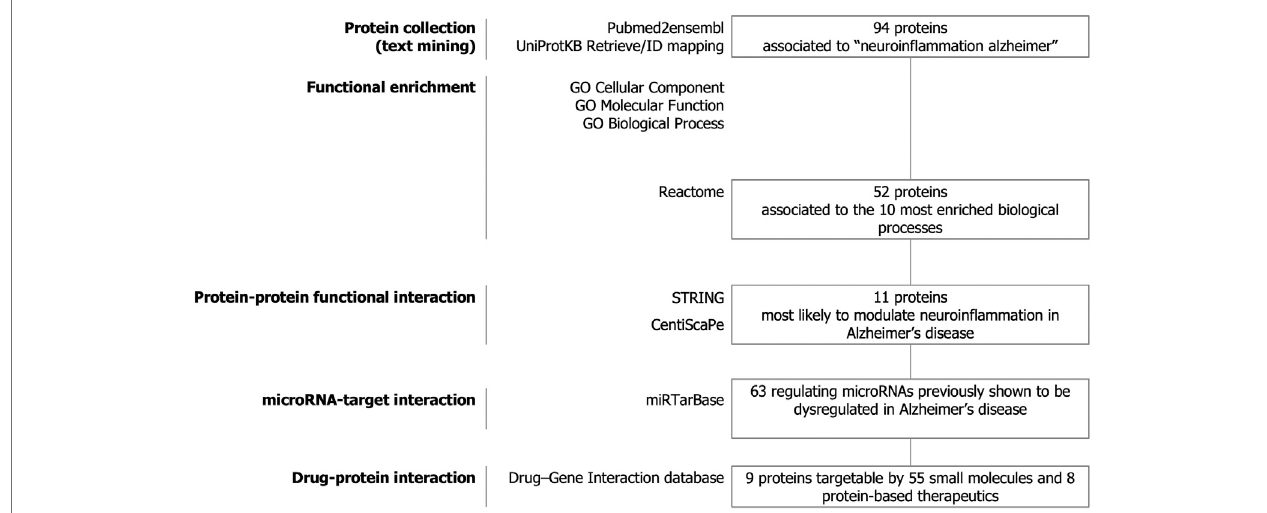
FIGURE 1 | Study design. Text-mining was used to support large-scale screening of the scienti fi c literature to collect 94 proteins related to neuroin fl ammation in Alzheimer ’ s disease. The entire dataset was analyzed for functional enrichment by using Gene Ontology (GO) cellular localization, molecular functions, biological pathways and by using the Reactome Pathway database and 52 proteins were associated to the 10 most signi fi cantly enriched pathways. Protein-protein functional interaction using STRING and CentisScaPe allowed us to identify 11 key proteins most likely to modulate neuroin fl ammation in Alzheimer ’ s disease. Finally, non- codingRNA-targetinteractionanddrug-geneinteractionanalysisshowedthatthekeyproteinswereindexedtobetargetablebyatotalof63microRNAsdysregulatedin Alzheimer ’ s disease and by 55 small molecules and 8 protein-based therapeutics.